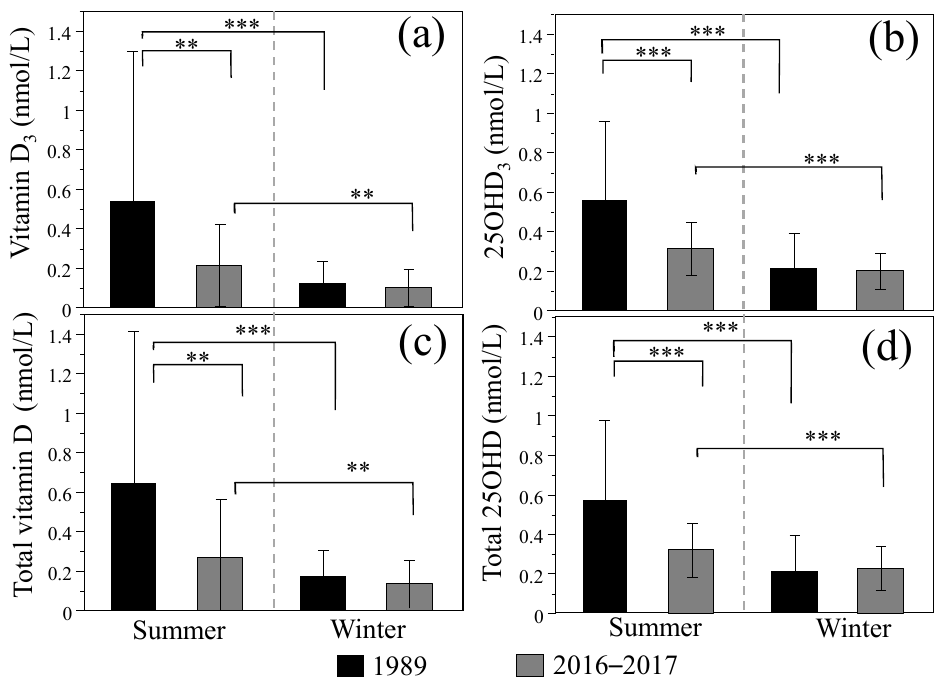
Figure 2. Breast milk vitamin D and 25-hydroxyvitamin D (25OHD) concentrations divided by season in 1989 and 2016–2017. Vitamin D 3 ( a ), 25OHD 3 ( b ), total vitamin D ( c ), and total 25OHD ( d ) concentrations in breast milk in the summer and winter. Solid bar: 1989, Gray bar: 2016–2017. Data are represented by the mean ± SD. Student’s t -test: ** p < 0.01, *** p < 0.001.